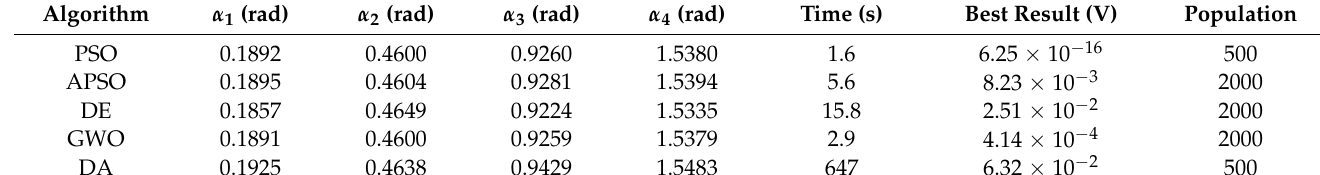
Figure 6. Summary of algorithms’ performance for a seven-level inverter. Table 4. Optimized switching angles for nine-level CHB inverter.